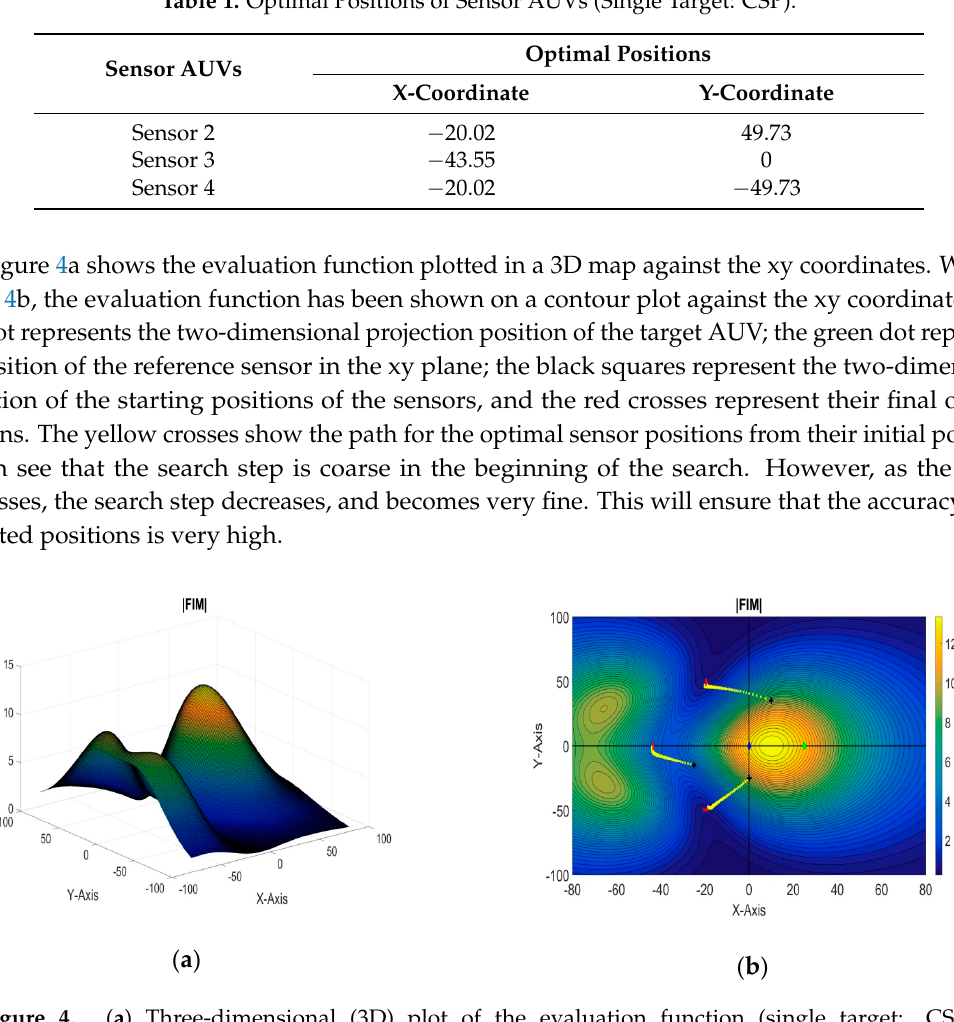
Table 2. Optimal Positions of Sensor AUVs (Single Target: CSP).